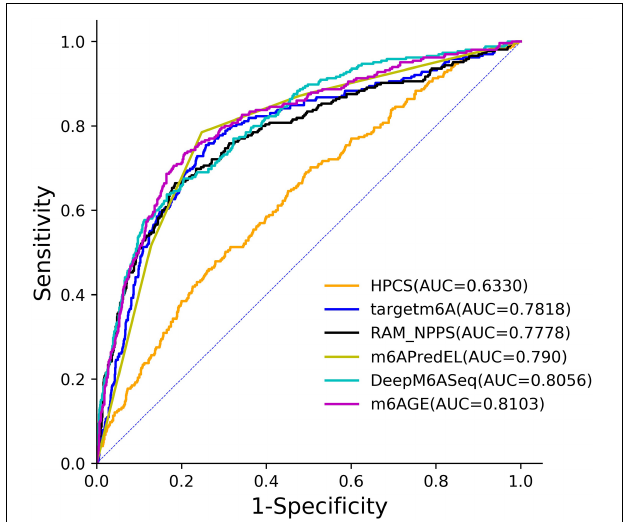
FIGURE 3 | The ROC curves of m6AGE and comparing predictors on the S21 datasets.